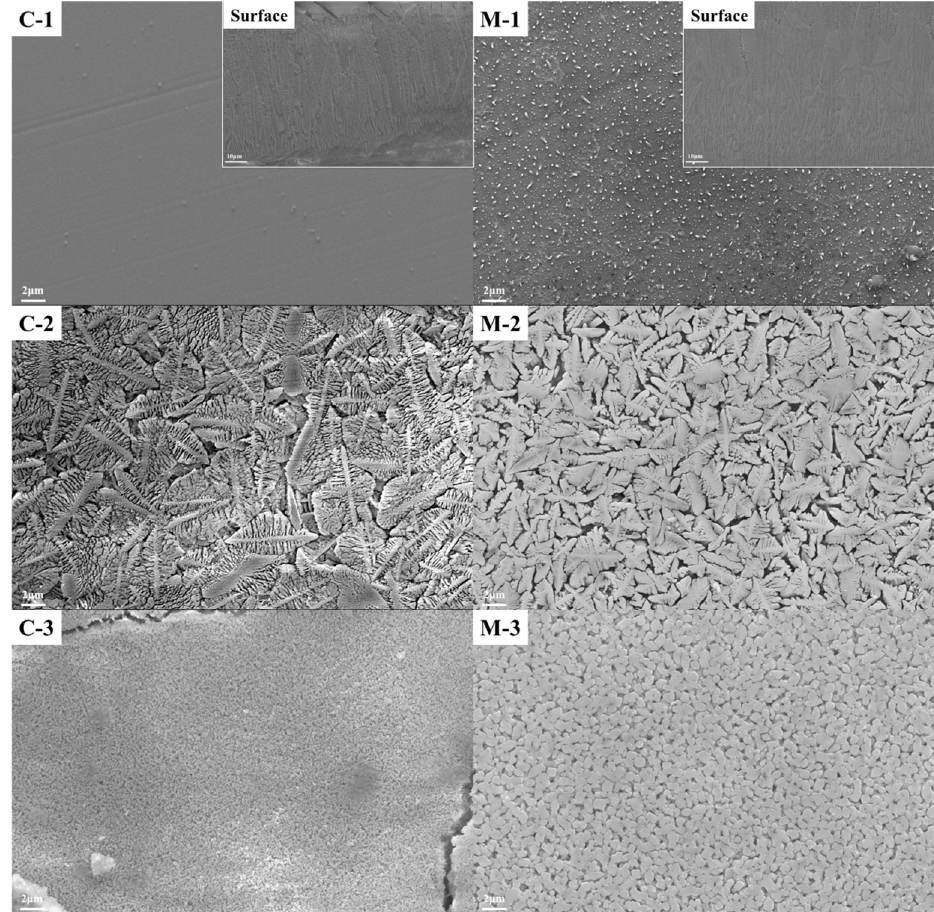
Figure 3. Scanning electron microscopy (SEM) images of glass-ceramics produced by conventional (C-n) and microwave (M-n) heating.